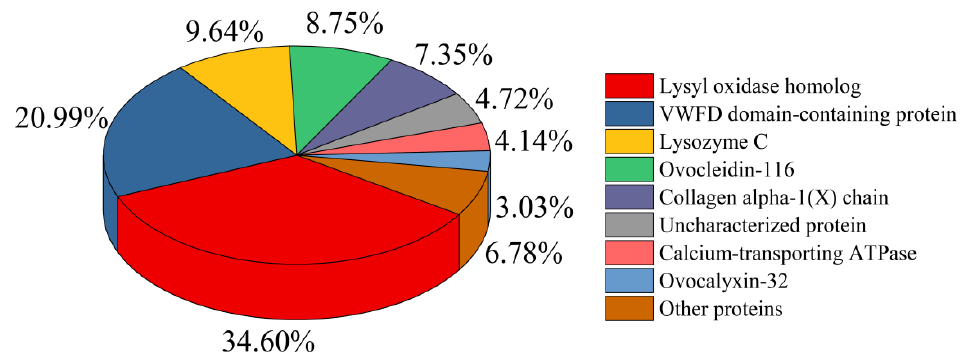
Figure 4. Percent distribution of identified peptides according to their parent proteins measured by Nano ‐ LC ‐ ESI ‐ MS/MS.